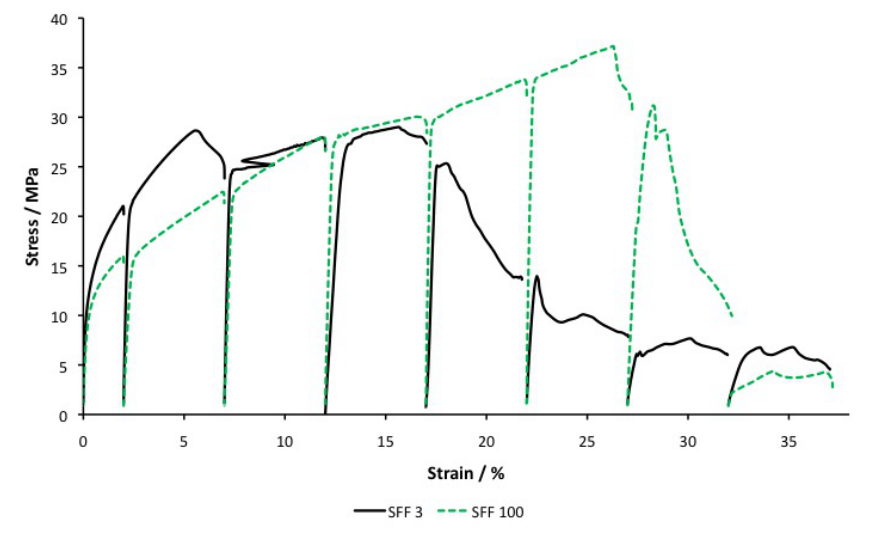
Figure 3. Stress-strain curves of SFF 3 and SFF 100 after eight steps of tensile